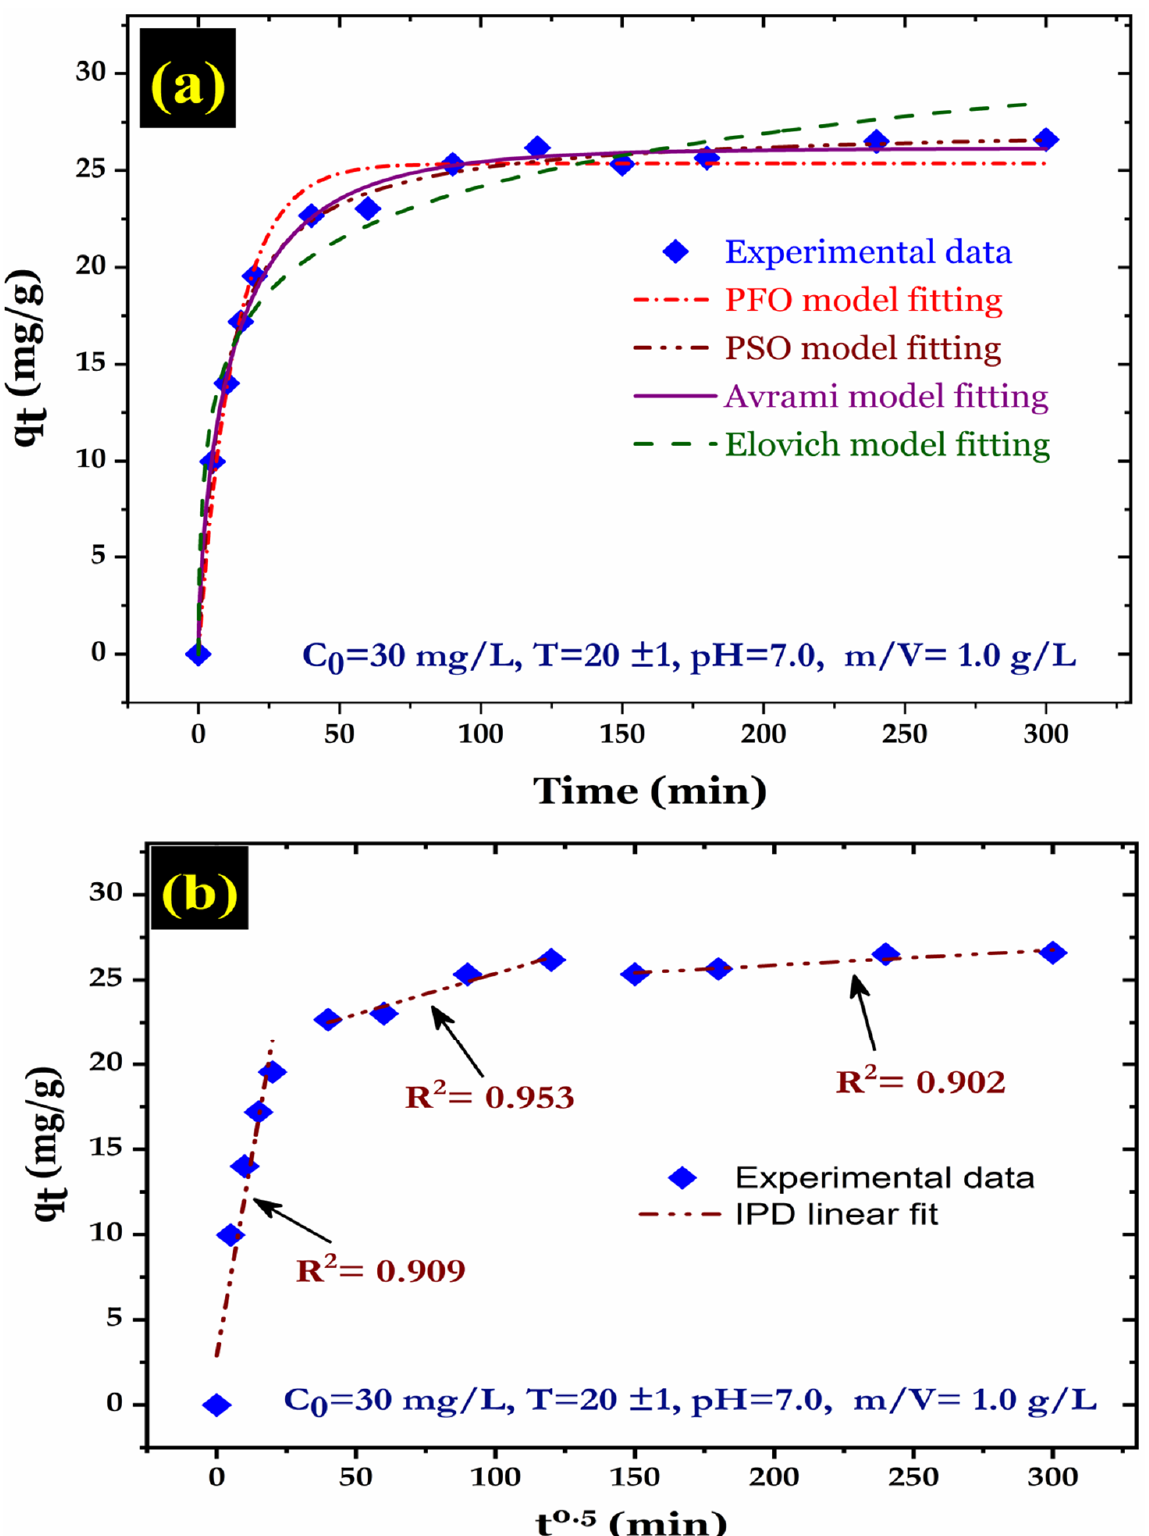
Figure 6. ( a ) Contact time effect, and nonlinear relationship of PFO, PSO, Avrami, and Elovich kinetic models, ( b ) linear relationship of intraparticle diffusion model.